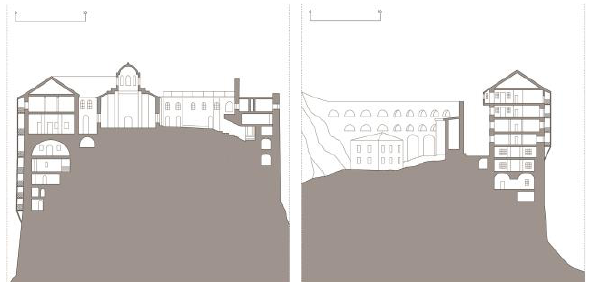
Figure 19 . The Monastery of Simonpetra. Cross-section and longitudinal section